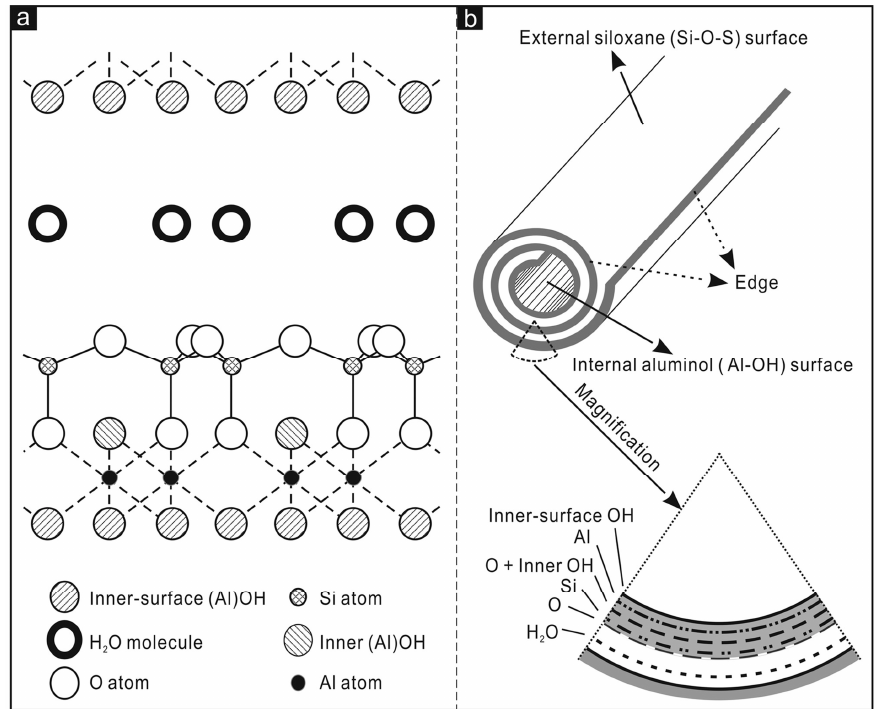
Figure 2. In ( a ) crystalline structure of halloysite-(10Å); ( b ) structure of a halloysite nanotube. Adapted from [61] .